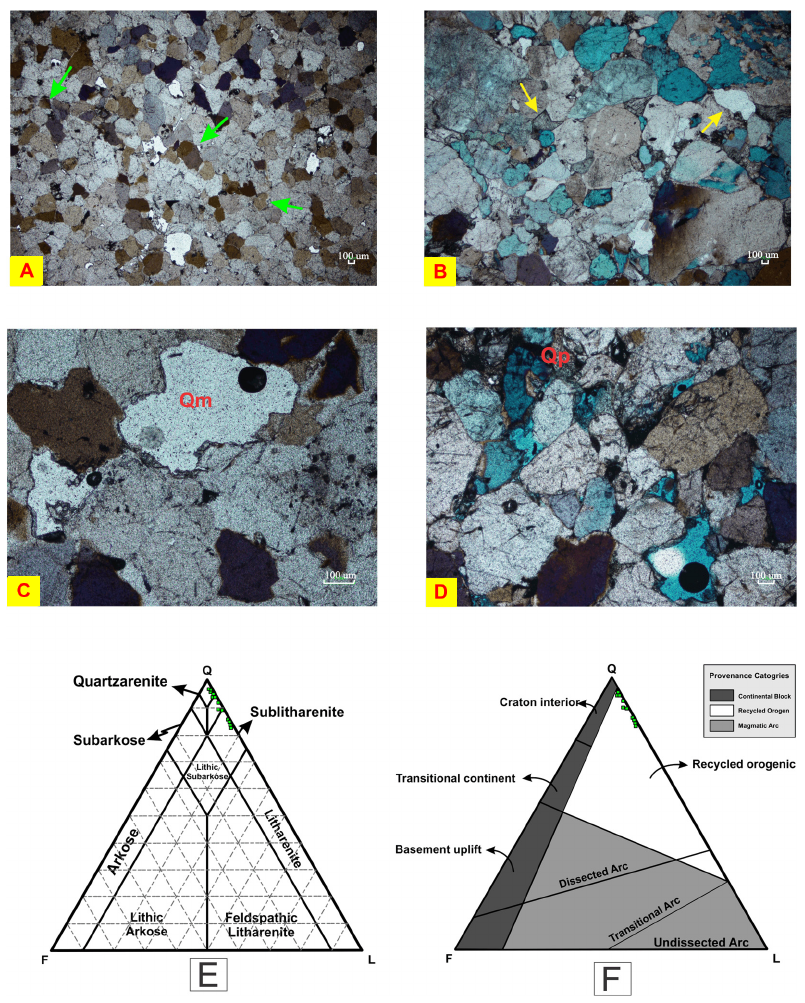
Figure 3. ( A ) Concave–convex contact highlighted by green arrows between medium- to coarse- grained sandstone; ( B ) plane contact highlighted by the yellow arrows; ( C ) (Qm) mono-crystalline quar tz grains; ( D ) (Cp) poly-crystalline quar tz grain; ( E ) classi fi cation of sandstone showing the quar tz -arenite with a few samples belonging to sub-litharenite; and ( F ) classi fi cation showing the Cratonic interior origin of the sandstone [20–22].